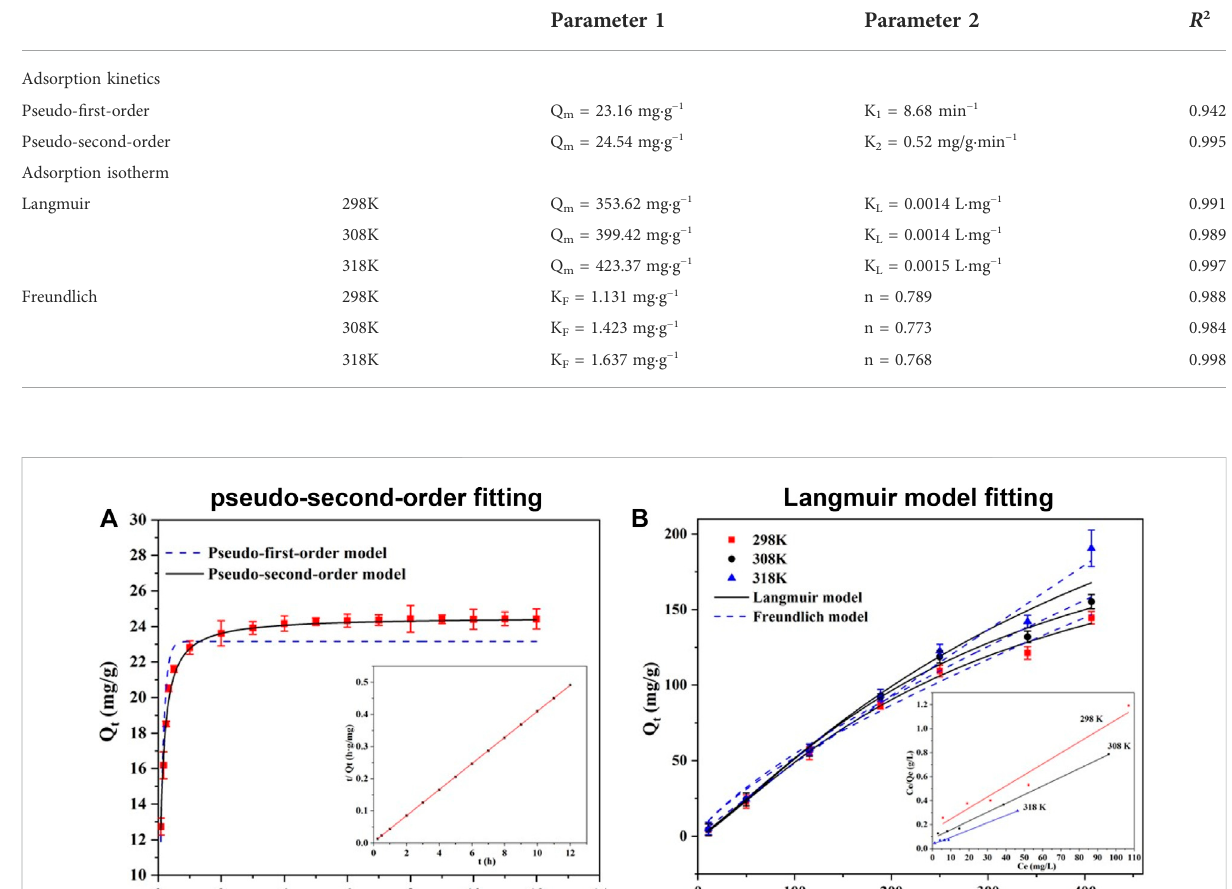
TABLE 2 Kinetic and isotherm model fi tting parameters.